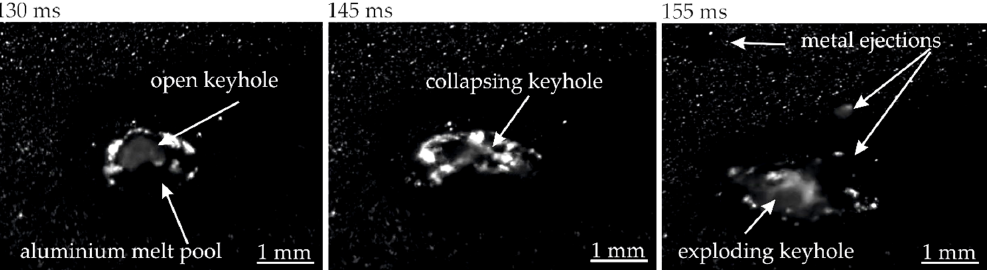
Figure 16. The melt pool dynamics and metal ejections for 1936 W magnet power.